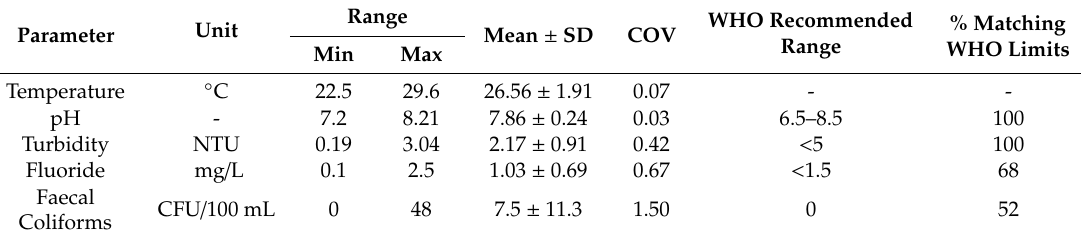
Table 3. Descriptive statistics of potable water quality parameters.